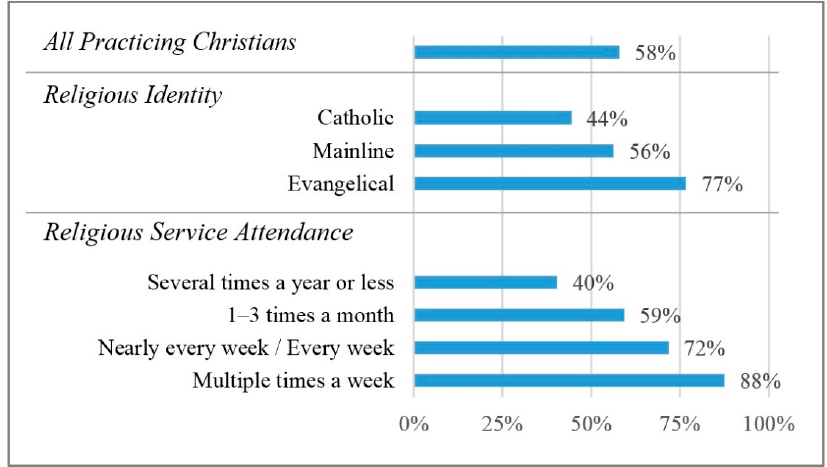
Figure 1. % of people who somewhat or strongly agree that skills and habits that they have learned from their faith community help them succeed at work (overall and by subgroup).